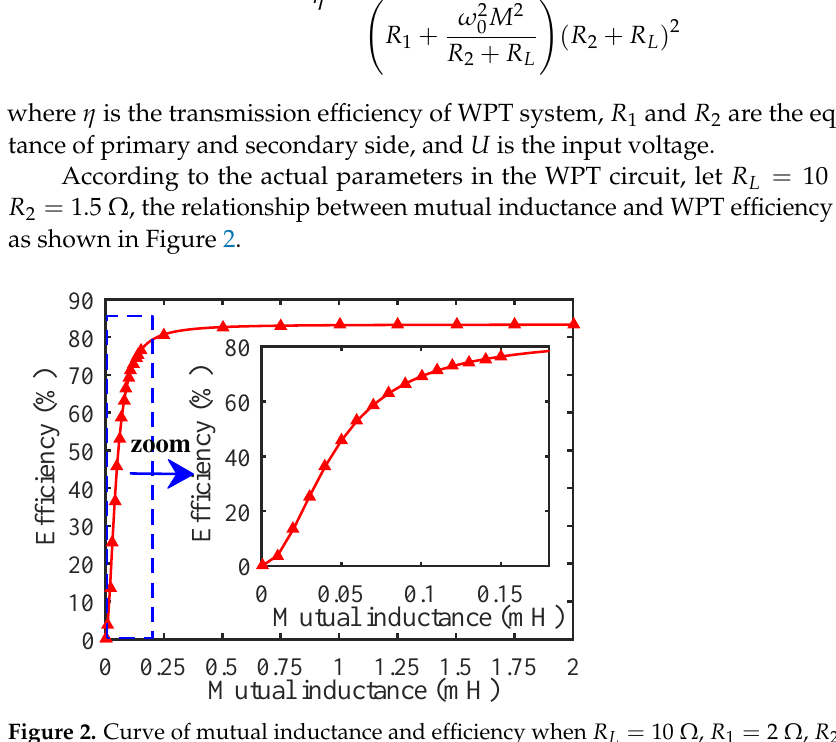
Figure 2. Curve of mutual inductance and efficiency when R L = 10 Ω , R 1 = 2 Ω , R 2 = 1.5 Ω